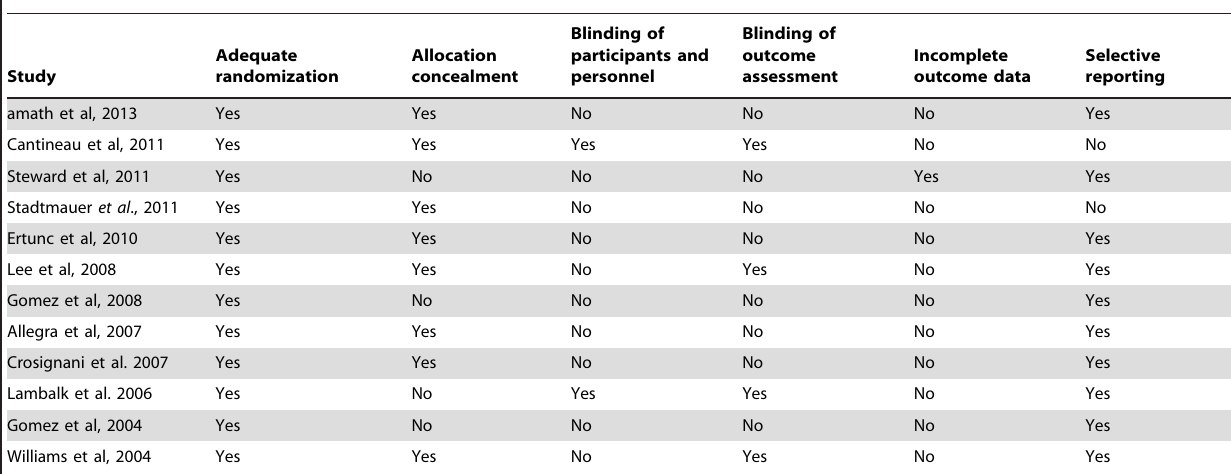
Table 3. Assessment of the risk of bias for included studies.